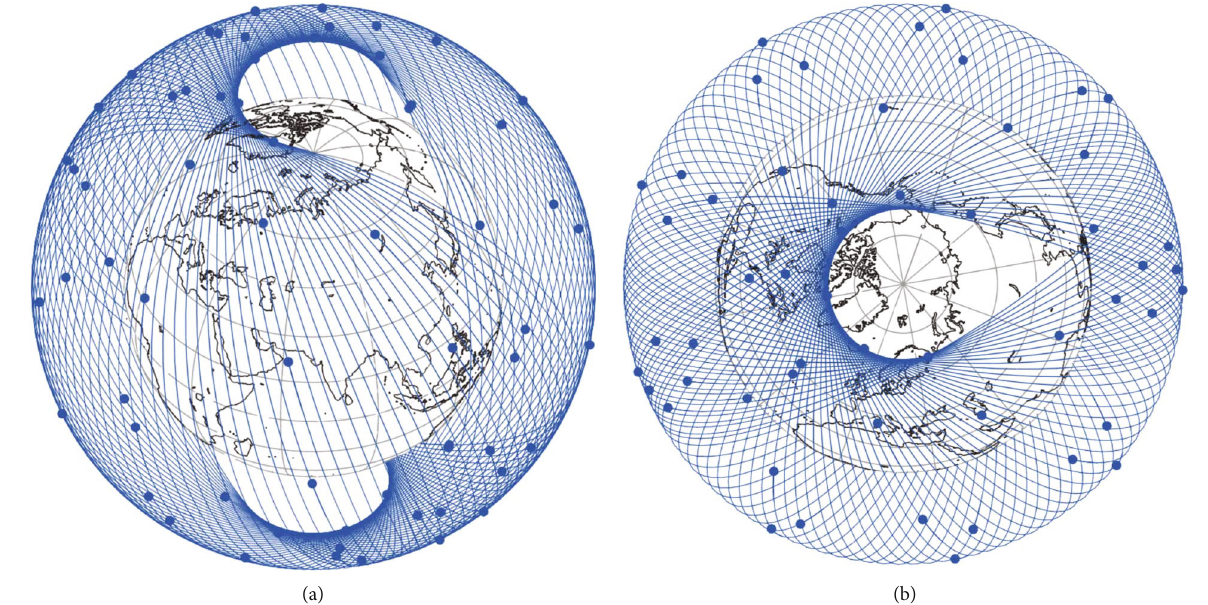
Figure 8: 70-satellite Flower constellation, which is the result for the optimization model with continuous object. (a) View from azimuth = 160 ° and elevation = 45 ° ; (b) view from azimuth = 110 ° and elevation = 90 ° .